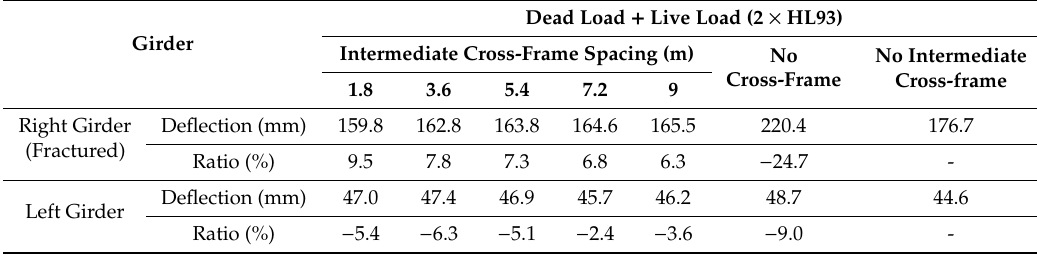
Figure 8. Finite Element Model of the fractured twin I-girder bridge. Table 5. Girder deflection of the twin I-girder bridge at mid-span under the dead and 2 times HL93 loading.